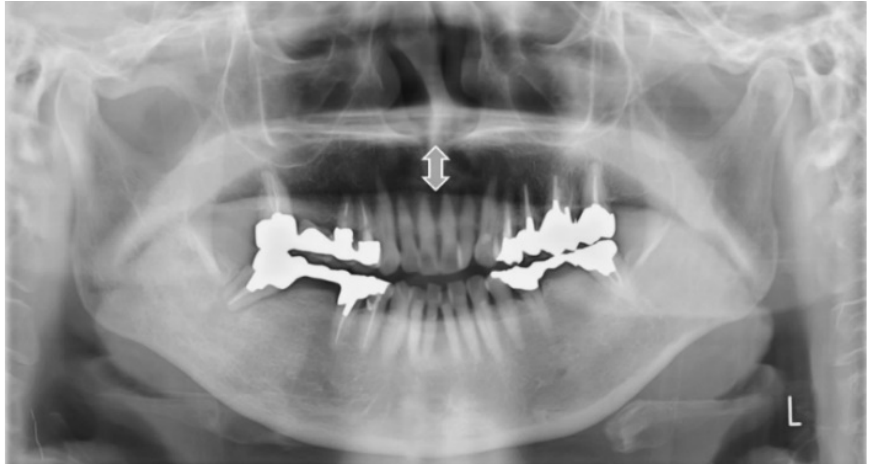
Figure 5. Measurement from the surface of the tongue to the palate on the midline (mm). Double sided arrow shows the measurement between the palate to